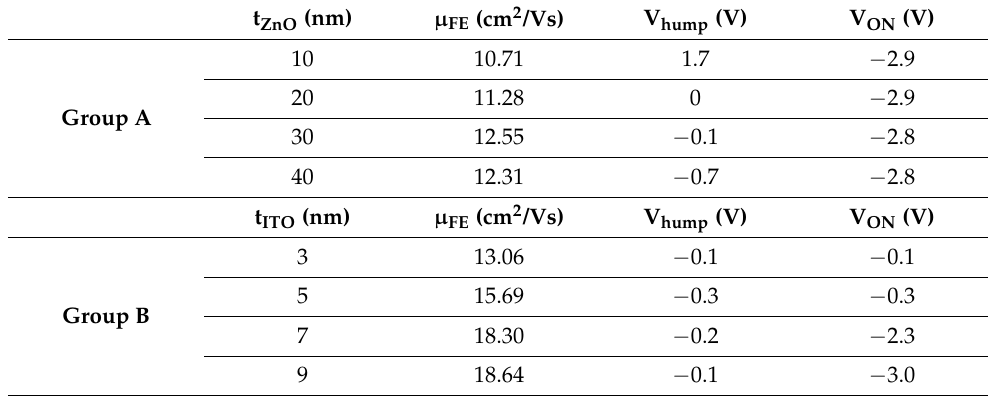
Table 2. Electrical parameters of ZnO/ITO TFTs, including µ FE , V hump , and V ON .